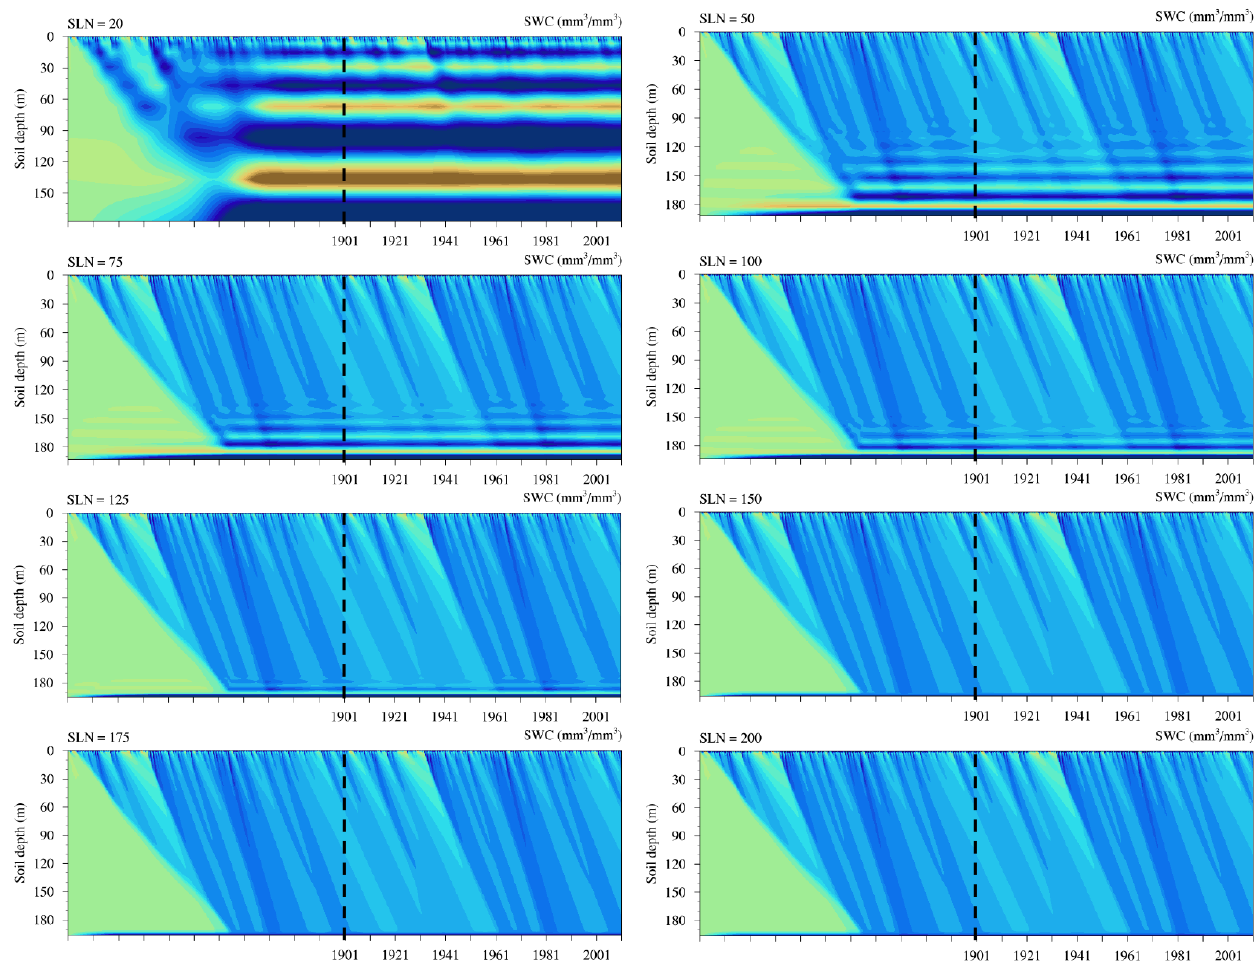
Figure 5. Simulated vertical monthly SWC profiles for the selected point in the WRB during both the spinup (left of the dashed black line) and simulation (right of the dashed black line) periods. All simulations were conducted with different SLN